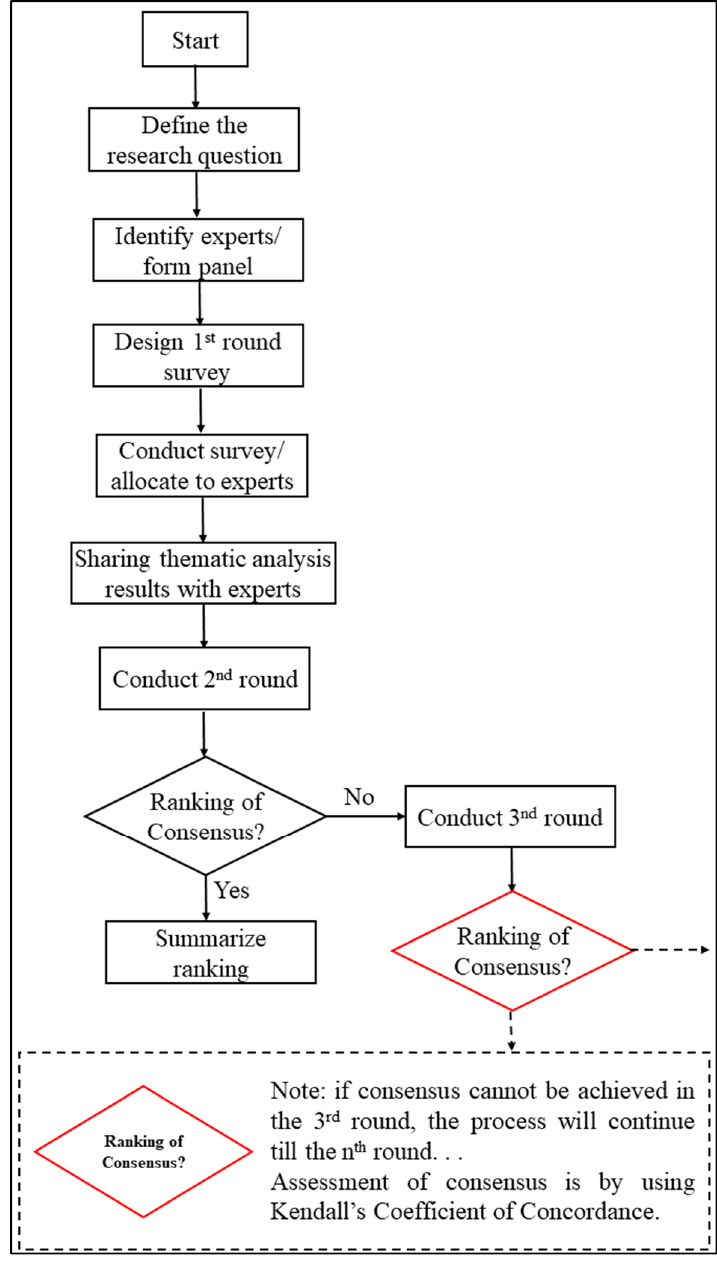
Figure 1. Flowchart of Delphi method.